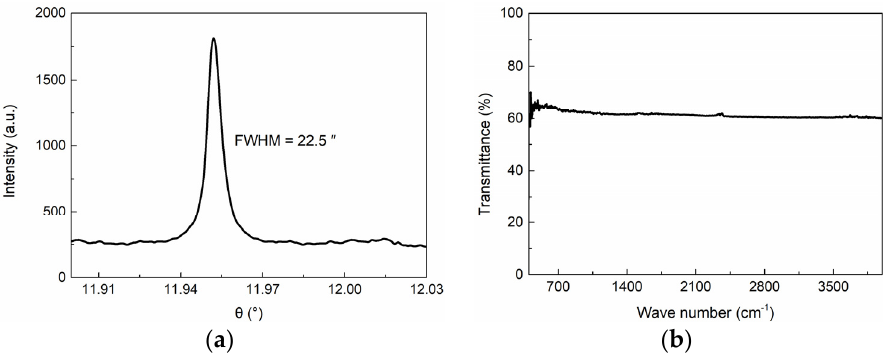
Figure 3. Elemental concentration along the growth direction measured using GDMS. ( a ) Zn distribution and ( b ) normalized In distribution. g is the normalized axial position in the ingot, where g = 0 corresponds to the tip of the ingot, and g = 1 is the tail of the ingot. The solid blue circles show experimental results and the red solid lines are fitting curves modeled using Equation (2).